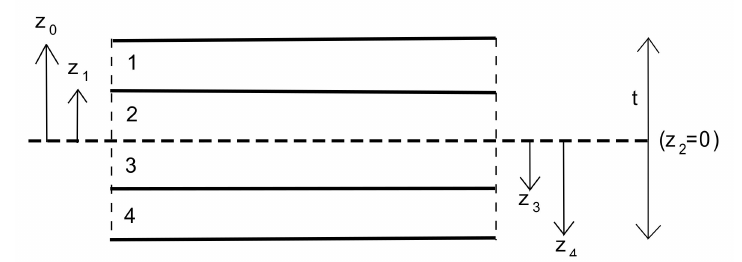
Figure A1. z-coordinates of layers.